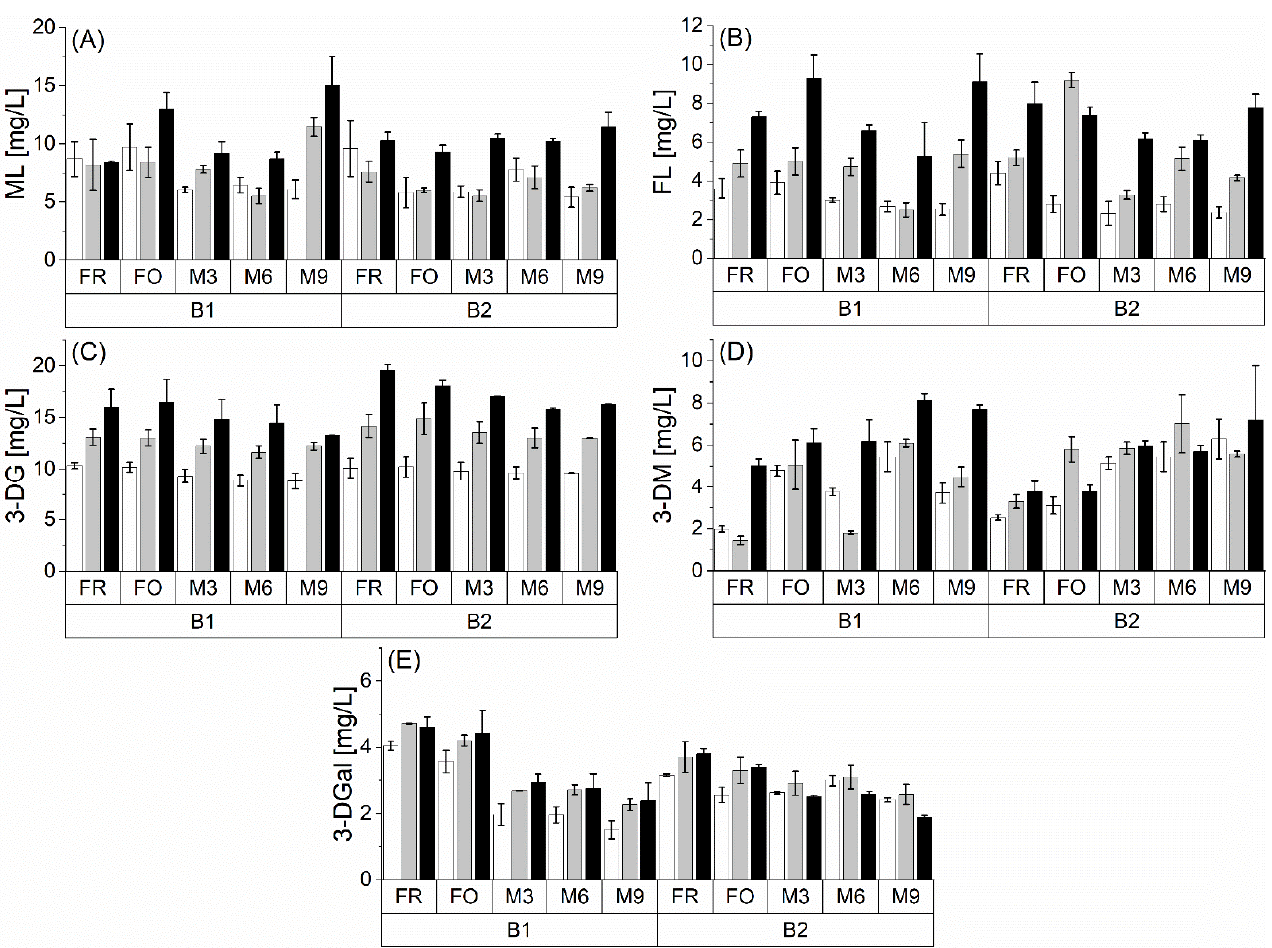
Figure 3. Concentrations of Amadori products (( A ) ML and ( B ) FL) and dicarbonyls (( C ) 3-DG, ( D ) 3-DM, and ( E ) 3-DGal) at fresh (FR), forcibly aged (FO), and naturally aged (M3, M6, and M9) beer at different malt modification levels (P1: white bar; P2: grey bar; P3: black bar) at two barley varieties (B1 and B2); n = 3 .